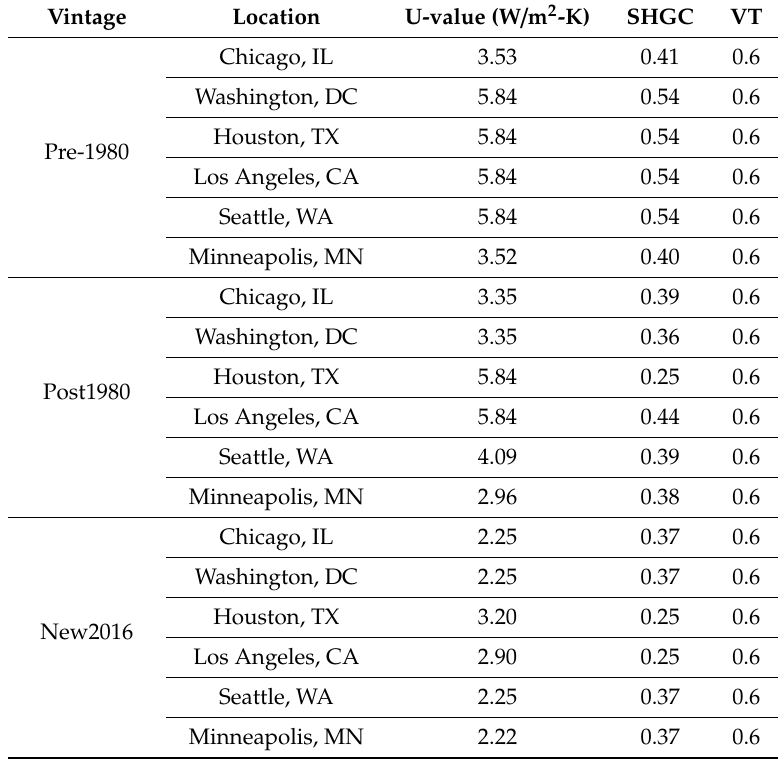
Table A2. Property of windows in di ff erent building vintages at di ff erent